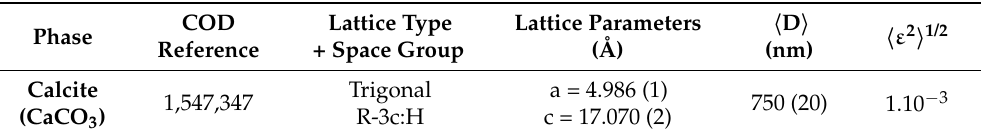
Table 6. Refined values of lattice parameters, unit cell volume, average diameter, microstrain 〈 ε 2 〉 1/2 . Standard deviations are indicated in parenthesis on the last